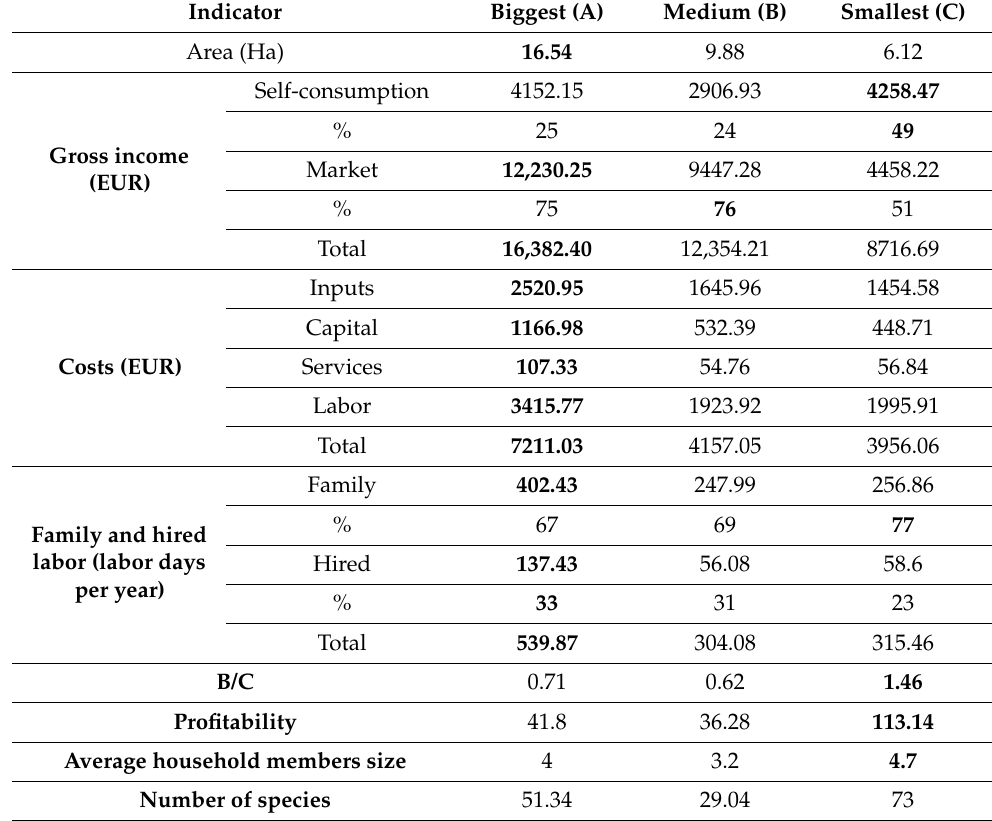
Table 3. Socioeconomic and environmental features of the cluster groups